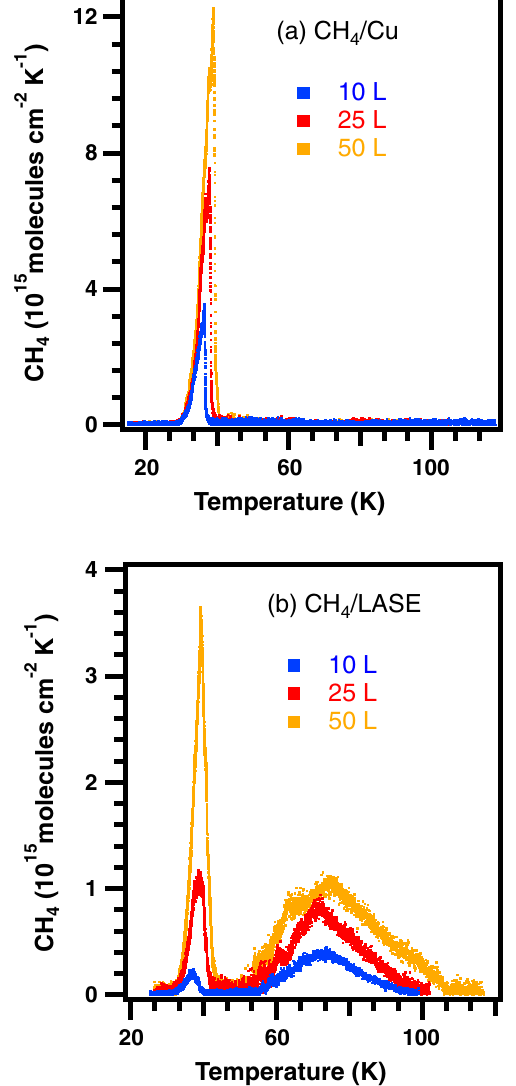
FIG. 4. TPD curves as a function of CH 4 dose on flat poly-Cu substrate (a); LASE-Cu sample